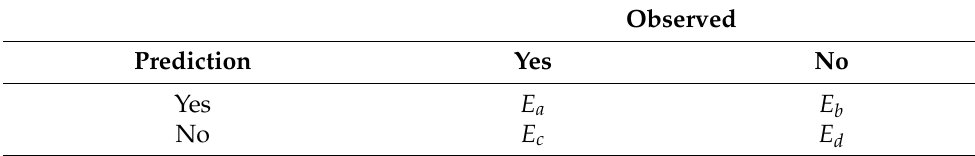
Table 4. Event costs for each